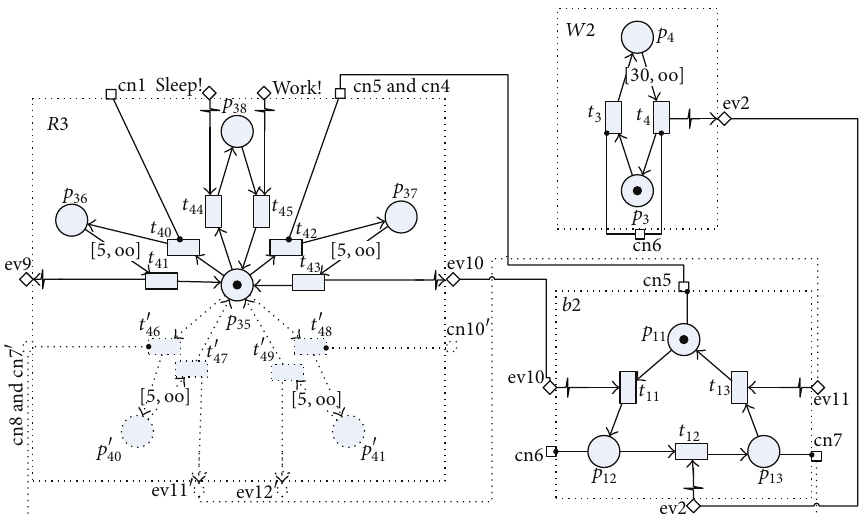
Figure 4: TNCES-based model of 𝑅 3, 𝑅 4, and 𝑊 2 in Mode